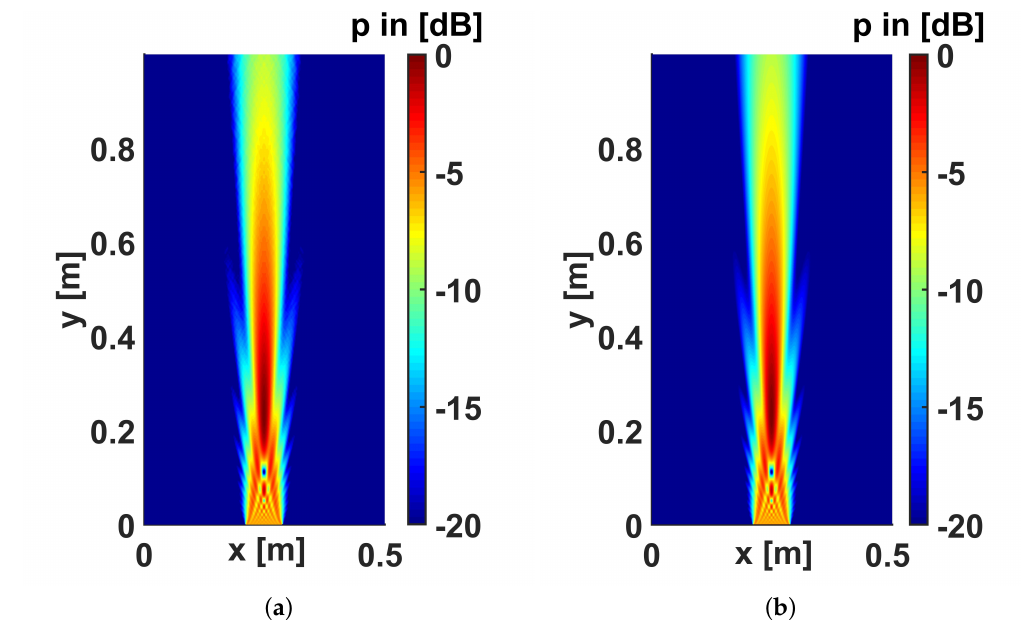
Figure 19. Amplitude distribution of the idealized circular piston transducer after forward propagation with the ( a ) spec-radiation method and ( b ) the re-radiation method. Normalized to the maximum in the volume.